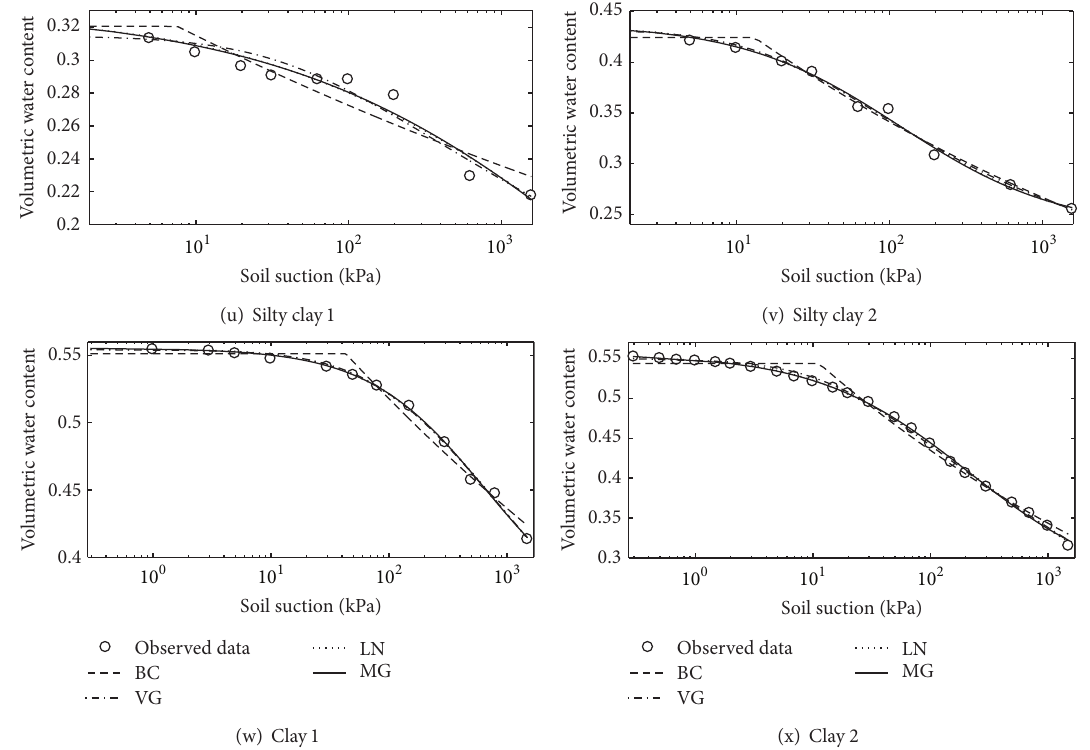
Figure 2: Observed and fitted soil-water characteristic curves (SWCCs) for sand ((a) and (b)), loamy sand ((c) and (d)), sandy loam ((e) and (f)), silt loam ((g) and (h)), silt ((i) and (j)), loam ((k) and (l)), sandy clay loam ((m) and (n)), silty clay loam ((o) and (p)), clay loam ((q) and (r)), sandy clay ((s) and (t)), silty clay ((u) and (v)), and clay ((w) and (x)). Numbers 1 and 2 represent soil samples 1 and 2, respectively, for each soil